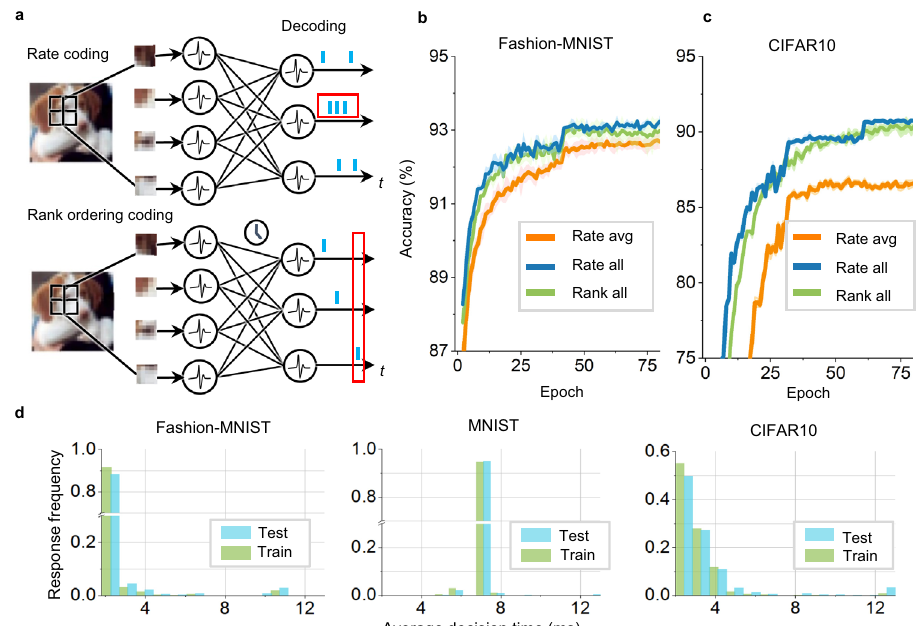
Fig. 2 The hybrid plasticity spiking neural network can fl exibly support different coding schemes and achieve a trade-off between performance and ef fi ciency. a Illustration of rate coding and temporal rank order coding. In rate coding, the network counts the number of spikes fi red by the output neurons as the output representation. In temporal rank order coding, the fi ring time of each neuron is regarded as an encoding of additional information, and the network determines the output in a winner-take-all manner where the fi ring order of the output neurons is used to output classi fi cation results. b , c Comparison of the training curves of the model with different coding schemes (called Rate-all or Rank-all) for the Fashion-MNIST ( b ) and CIFAR10 ( c ). The average and standard derivations over ten repeated trials are plotted. The average fi ring time over ranking coding schemes is counted and rounded up, and the rate-based model is tested with this average time window (called Rate-avg.). d Average response time for each testing category. We recorded the average response time steps required to produce results for each testing sample when running SNNs with rank order coding in an event-driven inference mode. After that, we counted these time steps and generated a normalized frequency